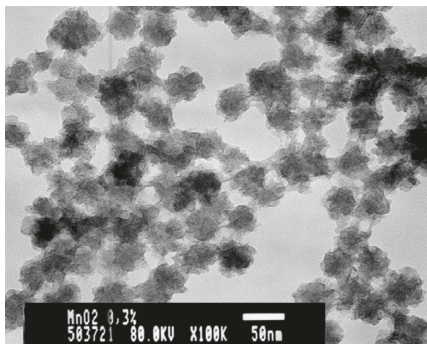
Figure 1: TEM micrograph of MnO